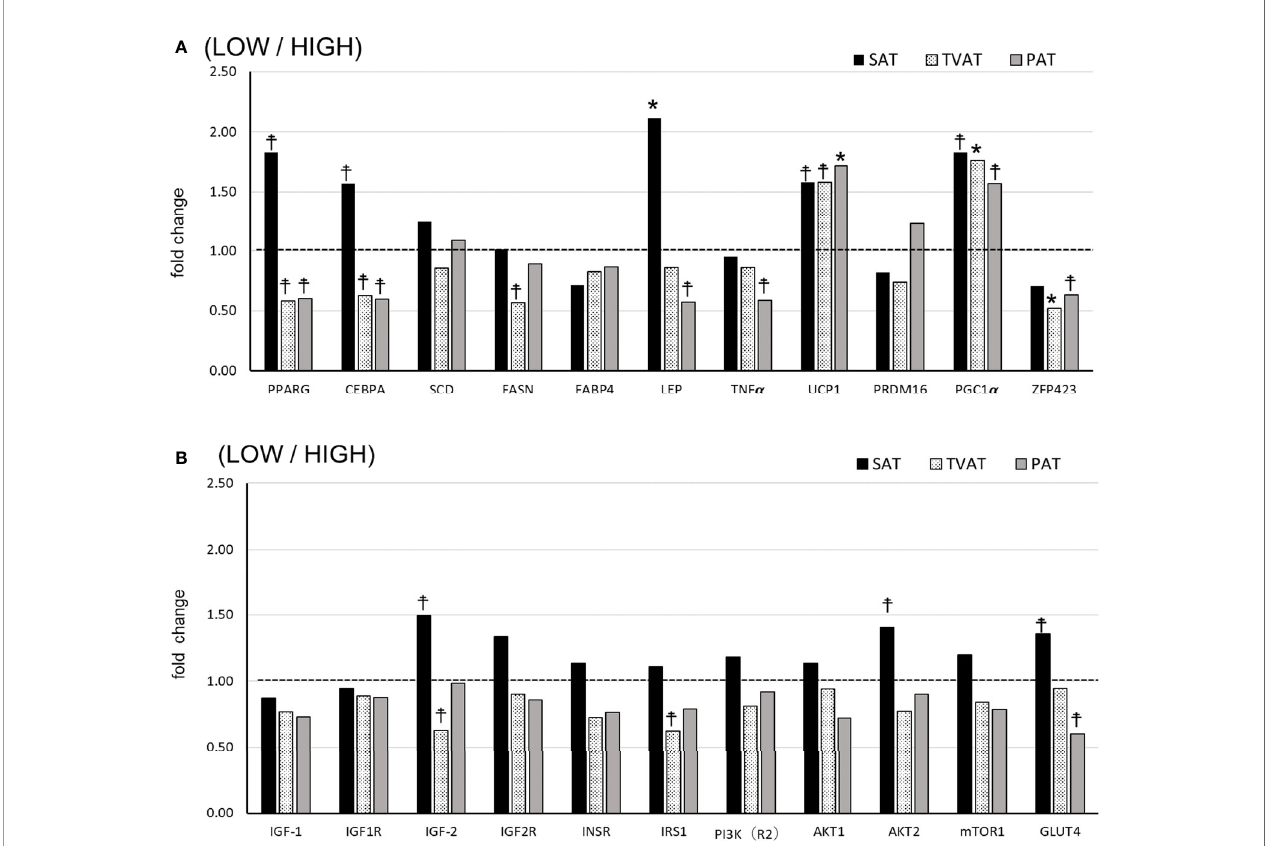
FIGURE 2 | Comparison of fold change of mRNA abundance in subcutaneous (SAT), thoracic cavity visceral (TVAT), and perirenal adipose tissues (PAT) between LOW and HIGH fetuses in Wagyu cattle. (A) Adipogenesis including brown adipose tissues (LOW/HIGH), (B) growth factors, and glucose metabolism (LOW/HIGH). The horizontal dotted line (at the value “ 1 ” ) showed the relative mRNA expression of the HIGH fetuses. The foldchange was calculated as the relative expression based on the mean of the target gene Ct value of LOW and HIGH fetuses. Fetuses: 260 ± 8.3 days of fetal age. LOW: n=6. HIGH: n=6. *Signi fi cant difference and ☨ trend ( p < 0.05 and p < 0.1, respectively) between LOW and HIGH